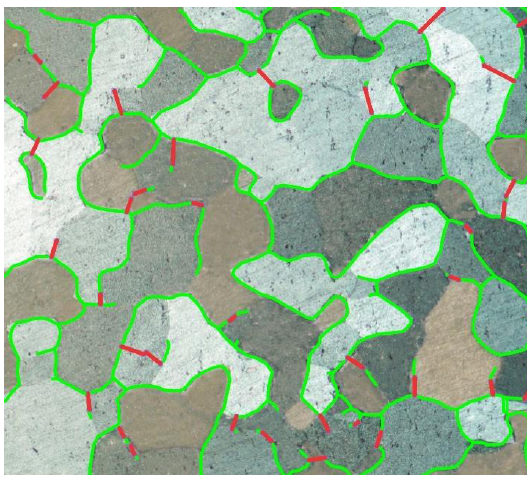
Figure 7. Procedure for connection of the edges procedure; green regions represents binary edge (BE), image combined green and red regions represent BE+. image combined green and red regions represent BE +